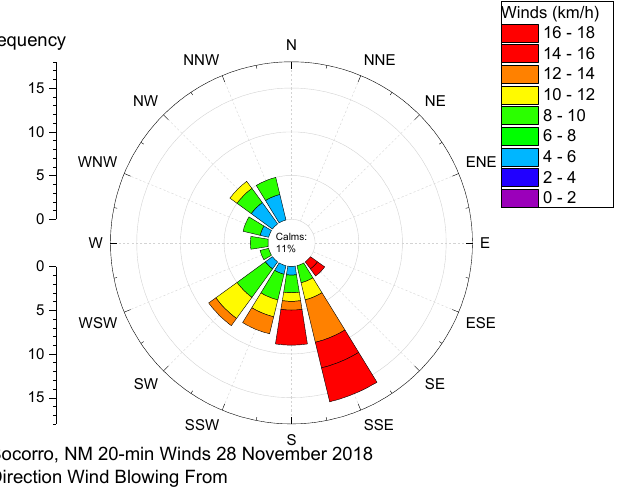
Socorro, NM 20-min Winds 28 November 2018 Direction Wind Blowing From Figure 6. Socorro, New Mexico, surface wind speed and direction data (20 min averages) plotted as a wind rose over 24 h on 28 November 2018.